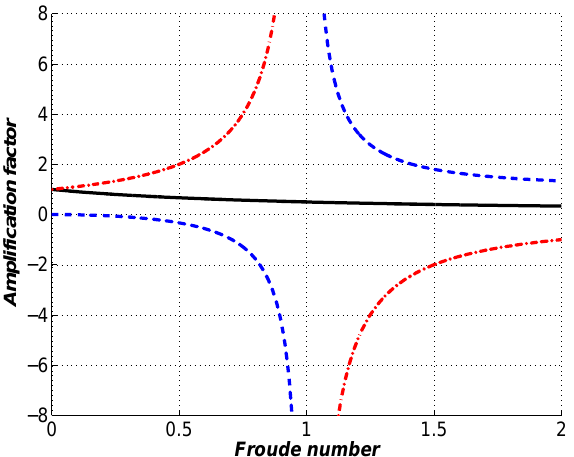
Fig. 3. Amplification factor for generated tsunami waves along the bottom profile h ∼ x 4 / 3 plotted against the Froude number: the forced wave (dashed blue line) and free waves propagating offshore (dash-dotted red line) and onshore (solid black line).